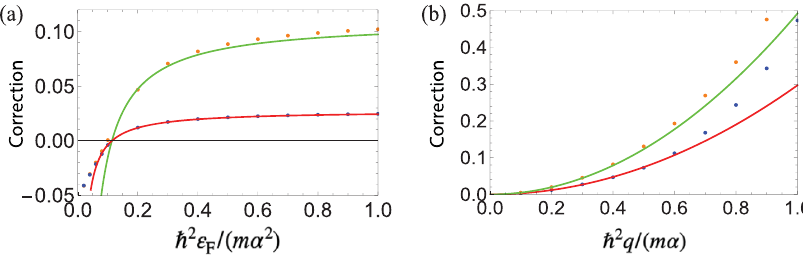
Fig. 2 The correction to the SHC. a The green and red solid lines are the correction q 2 σ ð 2 Þ yx with the dimensionless wave vector ℏ 2 q /( m α ) = 0.4 and ℏ 2 q / ( m α ) = 0.2, respectively. b The green and red solid lines are the correction q 2 σ ð 2 Þ yx with the dimensionless Fermi energy ℏ 2 ε F /( m α 2 ) = 0.4 and ℏ 2 ε F / ( m α 2 ) = 0.2, respectively. The correction is in the unit of e /(8 π ). The solid lines are drawn from Eq. (6). The dotted lines are drawn from the Kubo – Greenwood formula (Eq. (2)) with the corresponding